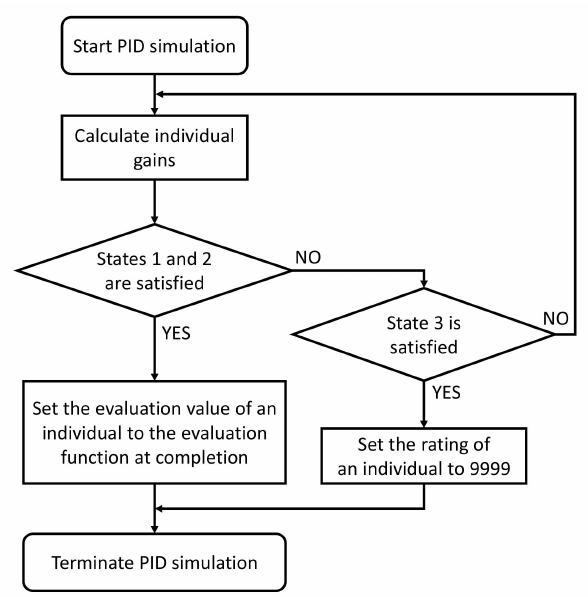
Figure 5. PID simulation